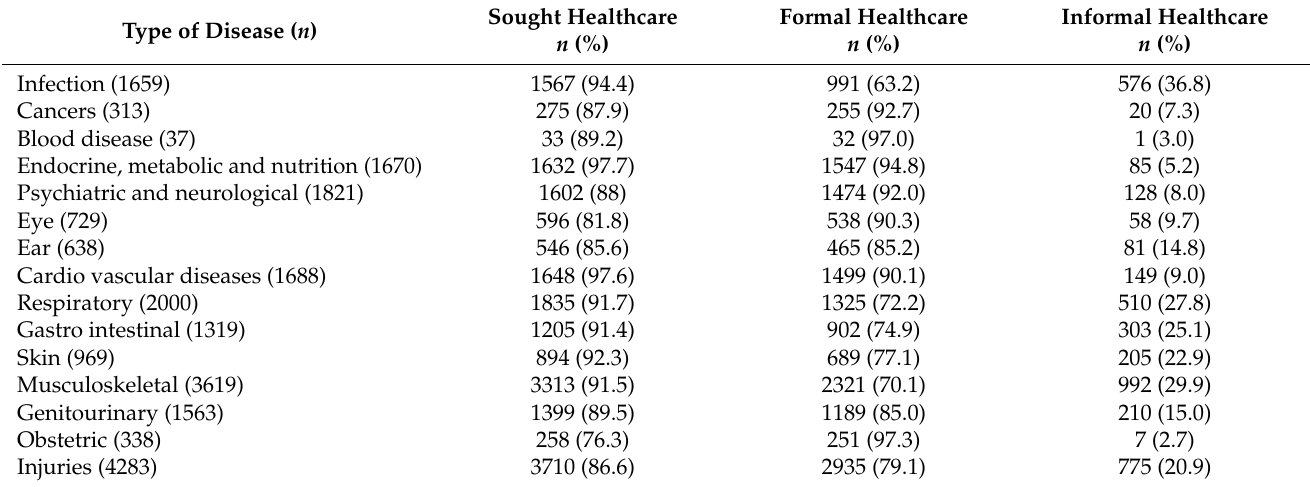
Table 2. Health-seeking behaviour across various diseases and their sub-analysis in formal and informal healthcare.